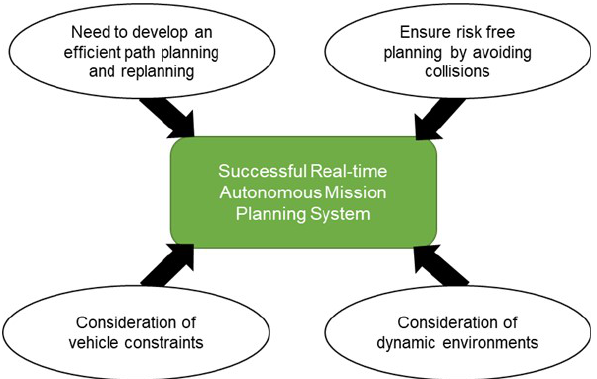
Figure 1. Challenges related to the development of a successful real-time autonomous mission planning system for a single